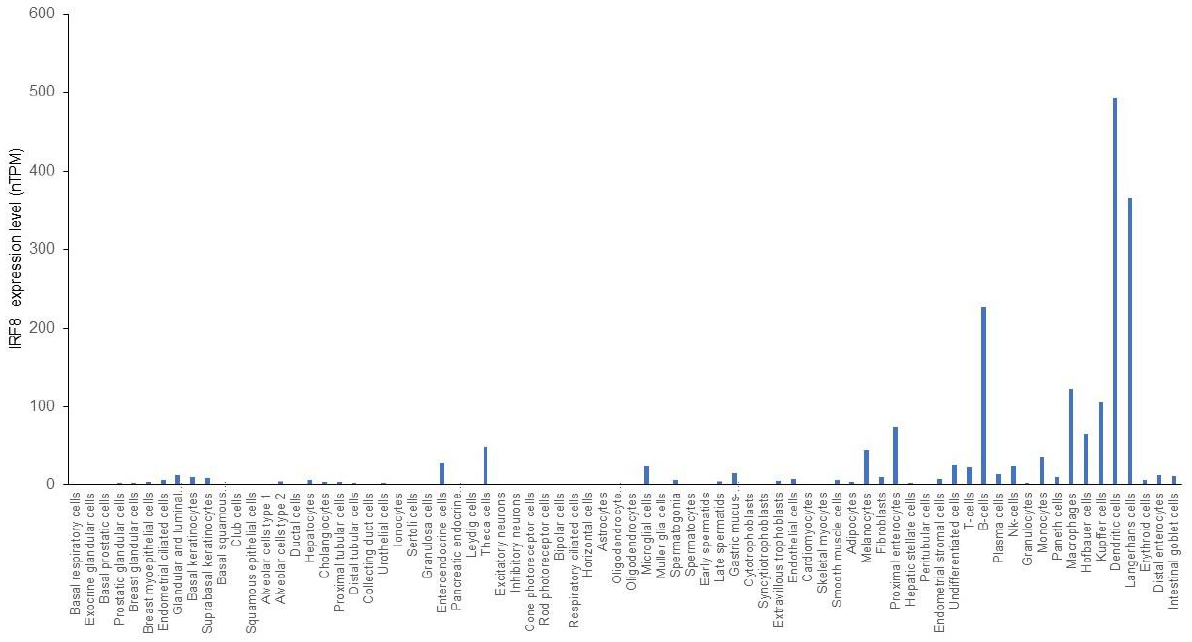
Figure 2. IRF8 expression profiles in human cells. Single cell RNA sequencing datasets were adapted from the human protein atlas.